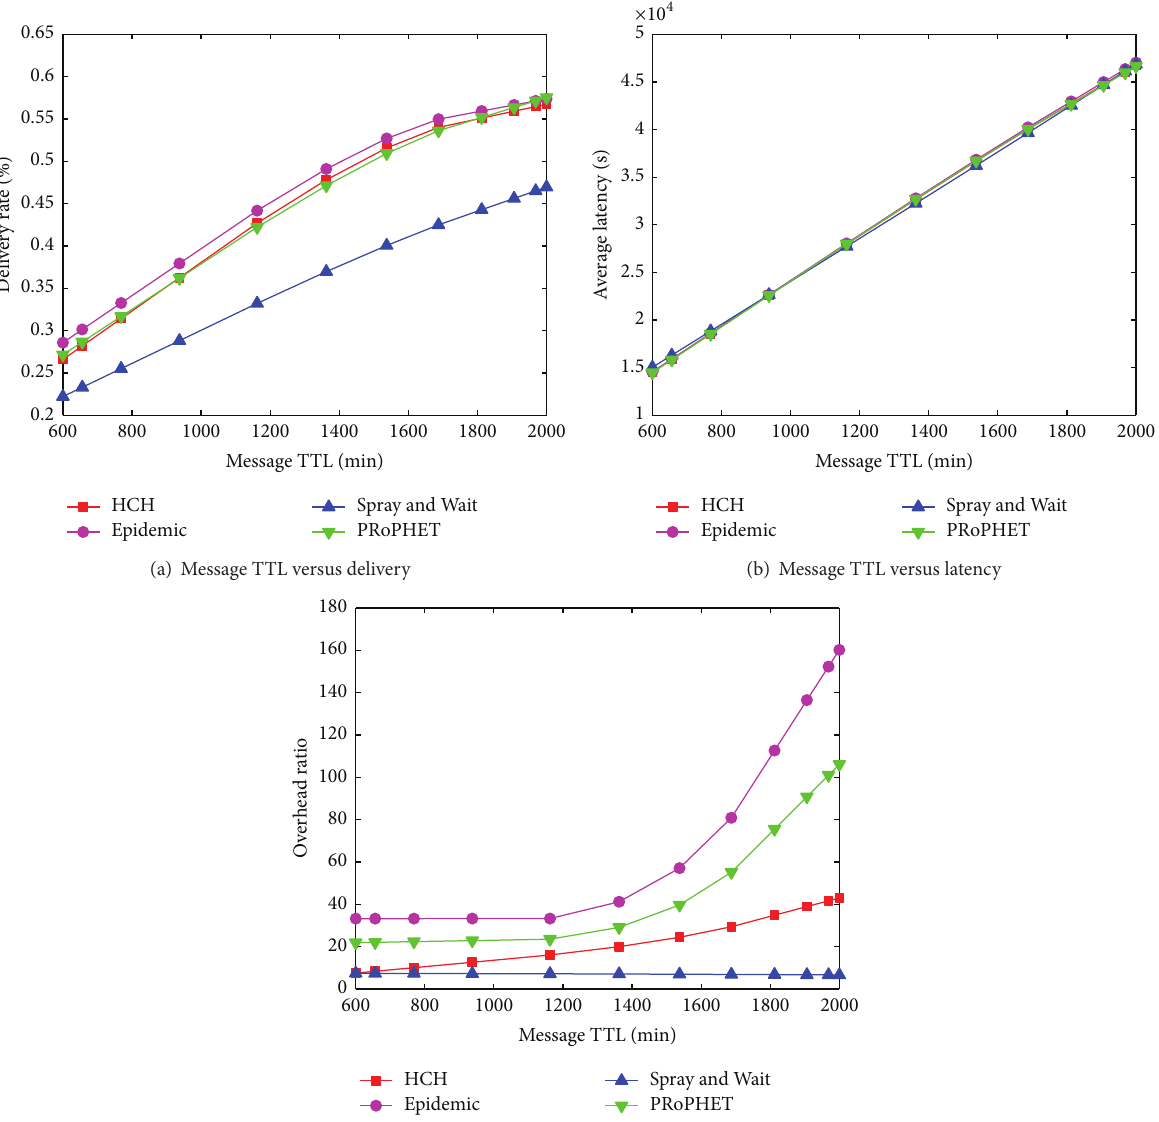
Figure 8: [Cambridge-iMote] Message TTL versus delivery ratio, average latency, and overhead